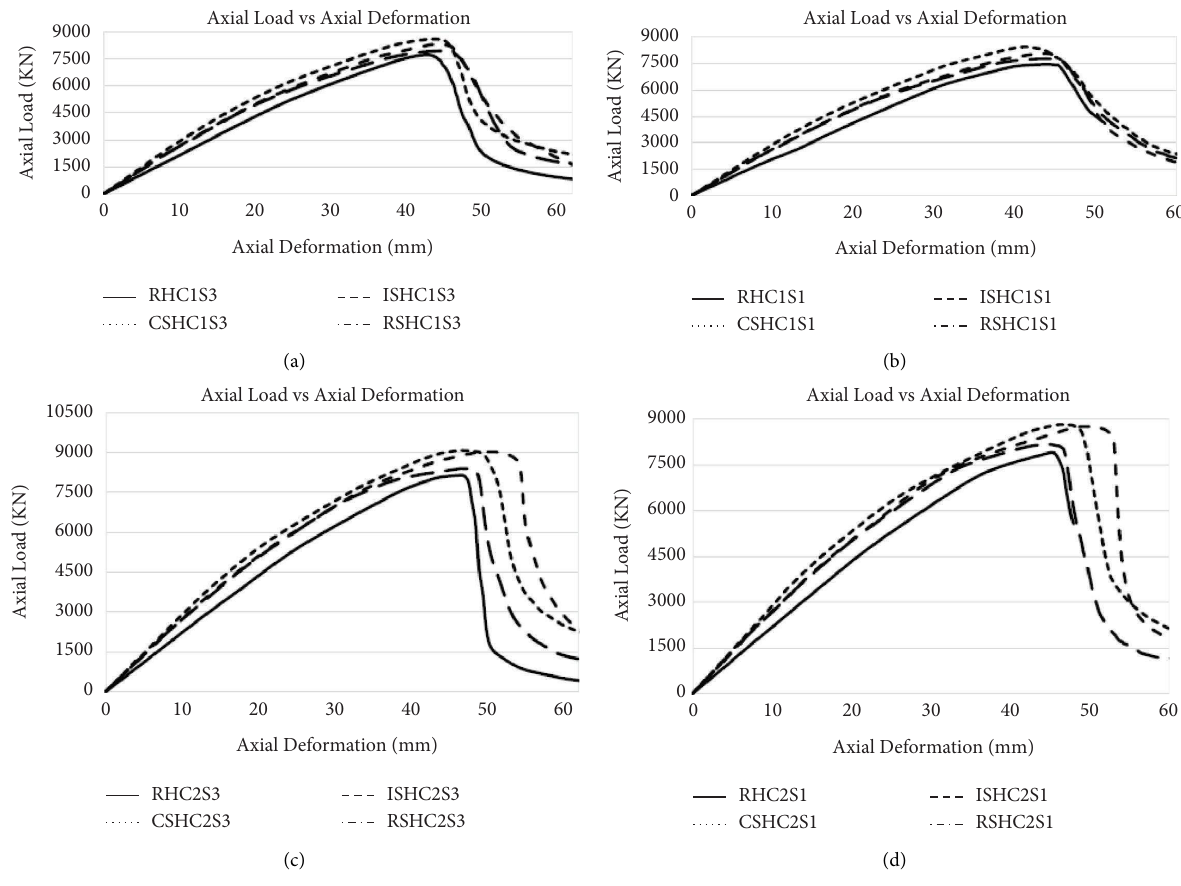
Figure 7: Efect of HSC on axial load-axial deformation response of (a) RC slender columns and FEC slender columns with (b) circular, (c) I-shaped, and (d) rectangular steel